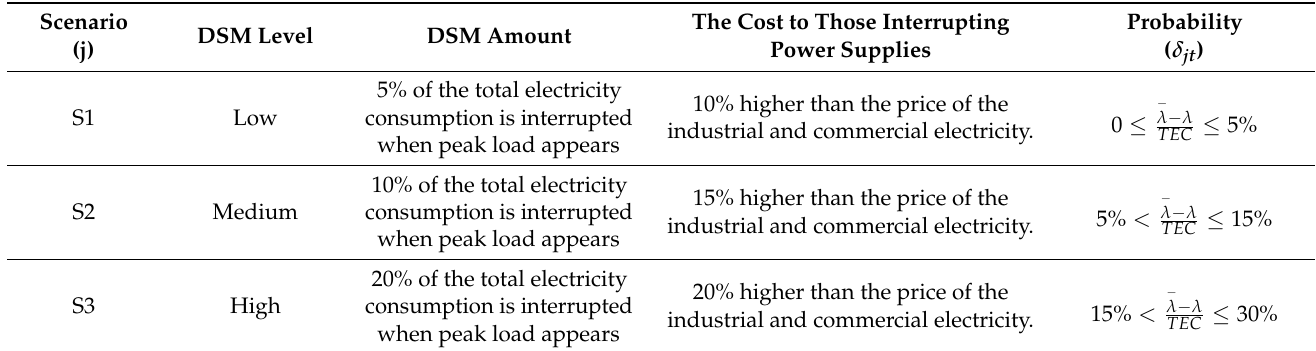
Table 5. The DSM scenarios and corresponding cost.